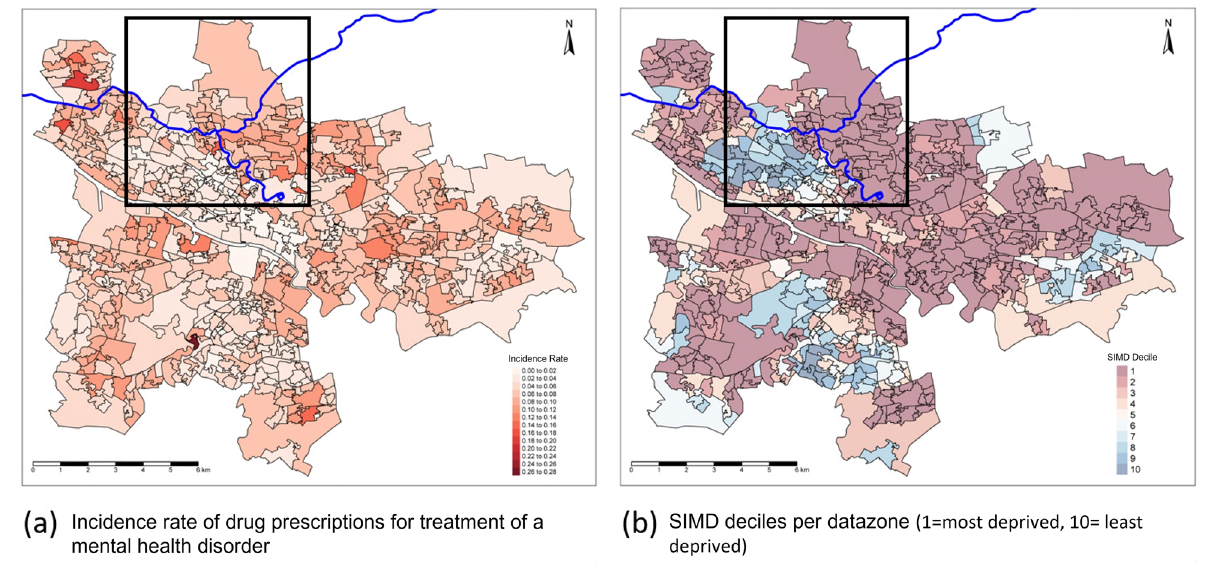
Figure 2. ( a ) Map of the incidence of drug prescriptions for treatment of a mental health disorder (number of people prescribed a drug for treatment of a mental health disorder/datazone population) for Glasgow in 2009 (starting date of analysis); ( b ) Map of Scottish Index of Multiple Deprivation (SIMD) 2004 deciles (1 = most deprived, 10 = least deprived) for each datazone in Glasgow. Blue line represents the canal in both maps. Study area within rectangle shape. *Maps were generated using R software version 3.6.1. 29 URL: https:// cran.r- proje ct. org/ bin/ windo ws/ base/ old/3.